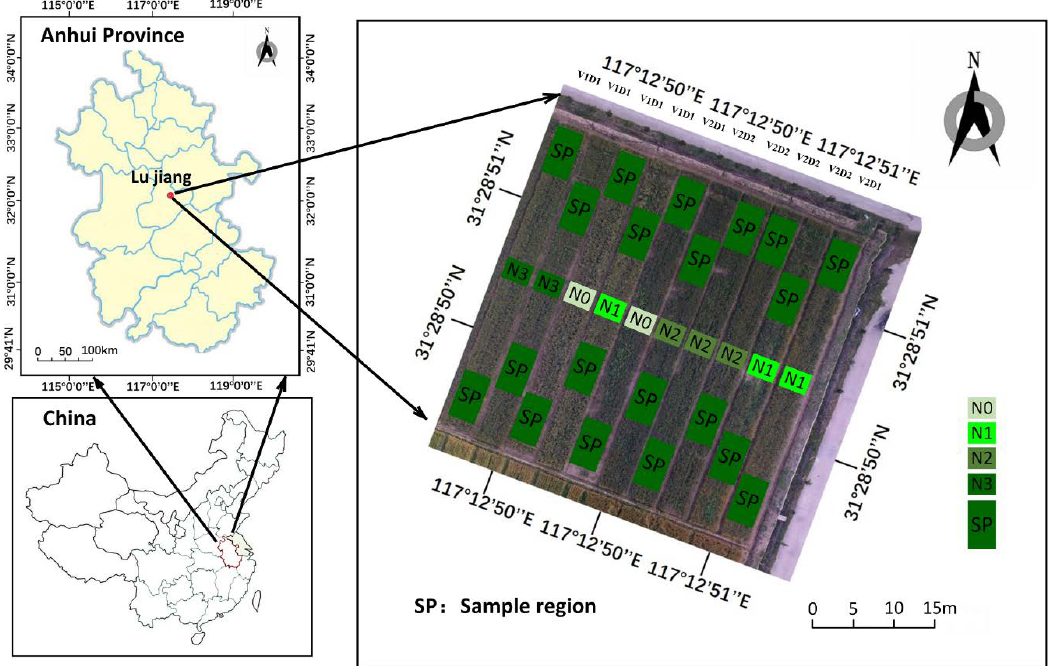
Figure 1. Location of the study area and the layout of field plots with wheat varieties, nitrogen levels, and sowing densities. Note: SP sampling region. D1 = 425 plants · m − 2 , D2 = 515 plants · m − 2 , N0 = 0 kg · N · ha − 1 , N1 = 104 kg · N · ha − 1 , N2 = 150 kg · N · ha − 1 , N3 = 220 kg · N · ha − 1 , V1 = ‘Wanmai 55’, and V2 = ‘Ningmai 15’.